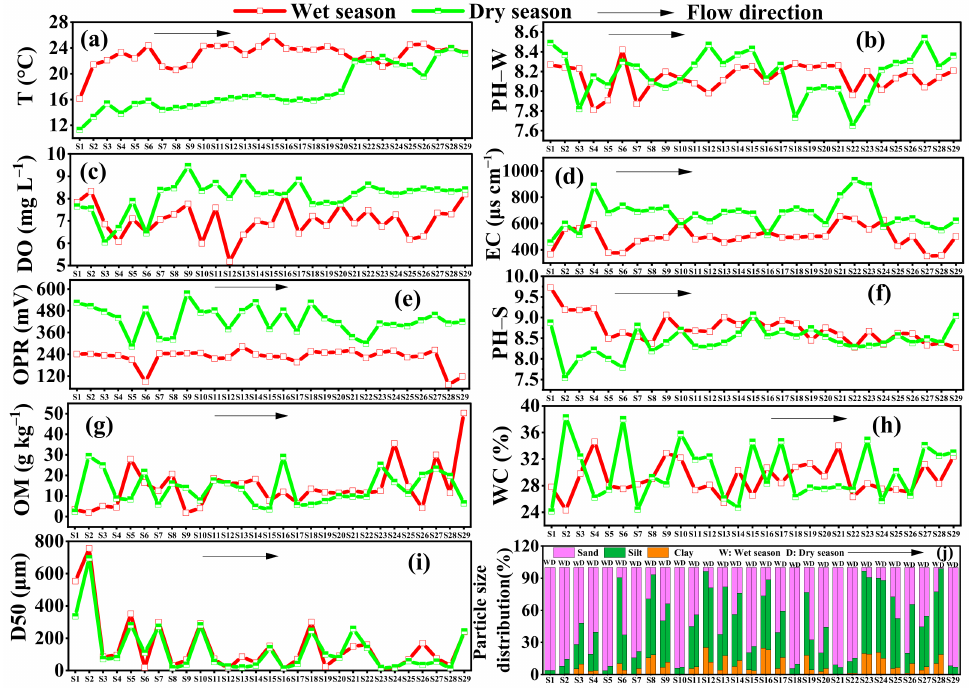
Figure 2. Spatial–temporal of physicochemical parameters: ( a ) temperature, ( b ) pH, ( c ) dissolved oxy- gen, ( d ) electrical conductivity and ( e ) reduction–oxidation potential of water, and ( f ) pH, ( g ) organic matter, ( h ) water content, ( i ) median sediment size, and ( j ) particle size distribution of sediments in the Tuojiang River (S1–S29 are defined in Figure